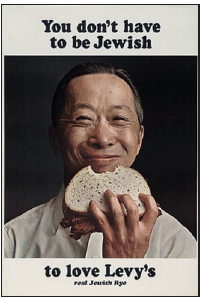
Figure 1: Not perfect looking white people. Magazine campaign for Levy’s. (DDB 1961–1970).